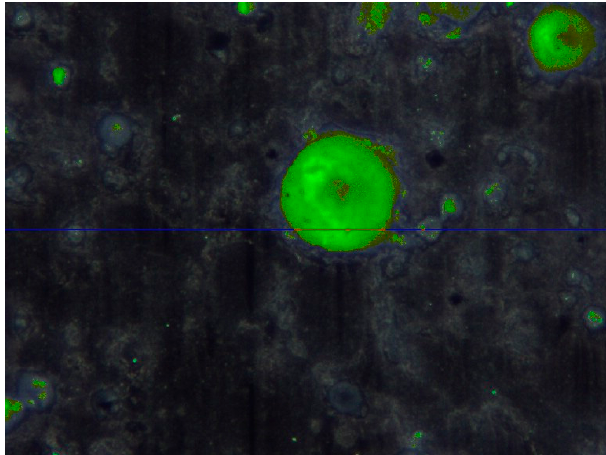
Figure 6. Scanning line of automatic air void analysis system.